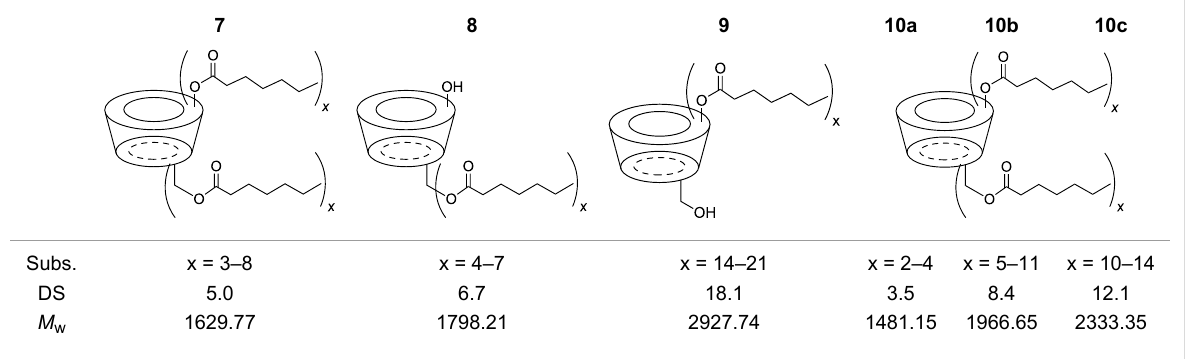
Table 3: Overview of the six amphiphilic CD derivatives used. Subs.: Number of substituents per CD molecule. DS: Degree of substitution. M w : Mole- cular